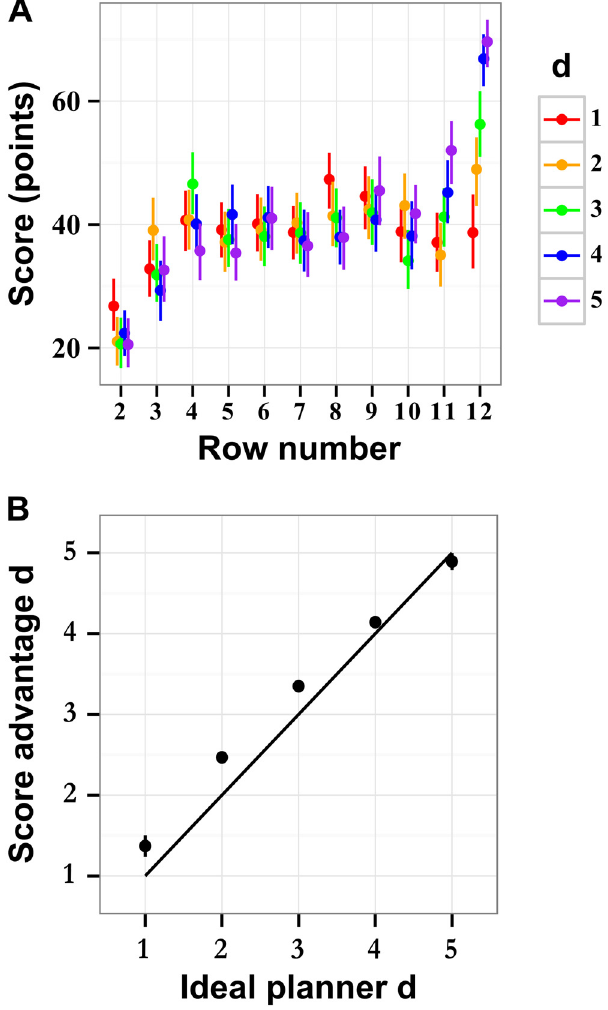
Fig 5. Effect of depth of computation on the score of ideal actor. (A) The scores collected by ideal actors with different fixed depths of computation d across stimulus rows. On the first rows, short-depth actors have an advantage over long-depth actors, which is reversed on the last rows. The largest gains are put off until the last rows. (B) A comparison of the average d from ideal actors with variable d to the best matching single d policy. The best match is chosen to minimize the score advantage on the last 3 rows. The solid line indicates perfect recovery. There is some systematic deviation, but the score matching algorithm recovers an approximation of the average d . All results are shown for a fixed recalculation period r = 1, points indicate mean value, and the error lines are bootstrapped 95% confidence